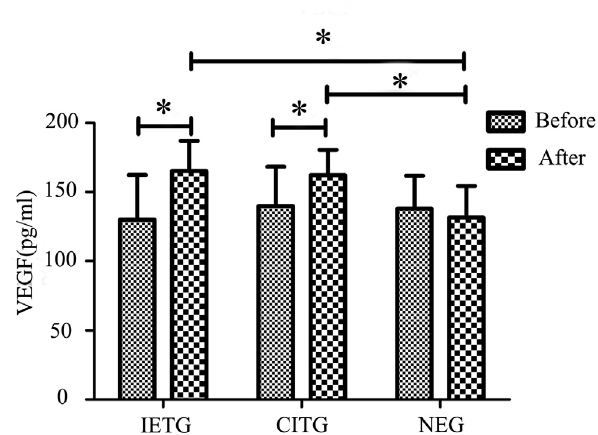
Figure 5: Comparison of VEGF level between the three groups